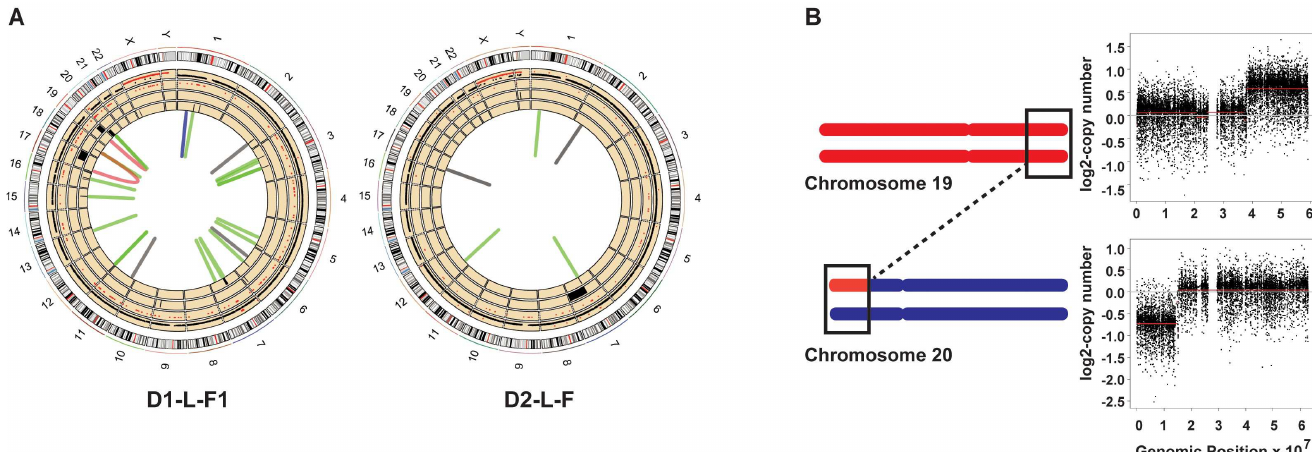
Fig 2. Structural changes detected in skin fibroblast clones D1-L-F1 and D2-L-F. (A) All genome changes detected in D1-L-F1 and D2-L-F clones. The tracks numbered from innermost are as follows: 1—structural changes. Green = deletions, black = duplications, blue = inversionsand red = translocations. 2—deletions as detected by read-depthanalyses. 3—amplifications as detected by read-depth analyses. 4—LOH events. 5— somatic SNVs, black dots are heterozygous SNVs and red dots are homozygous SNVs. (B) Schematic describing the chr19, chr20 translocation in D1-L-F1. Black rectanglesdepict region whereintranslocationevent was detected with a concomitantchange in copy